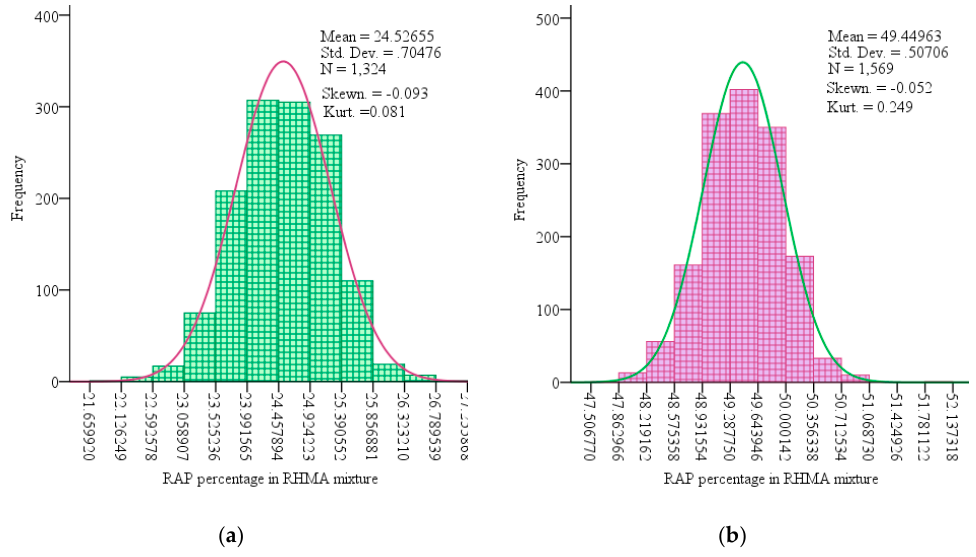
Figure 8. Normal distribution curves and statistical indices of histogram of RAP percentage content in recycled hot mix asphalt (RHMA) mixture, when its content according to JMF had to be: ( a )—25%; ( b )—50%.